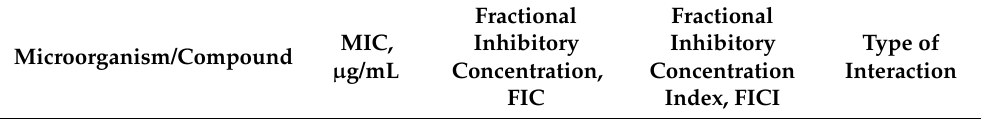
MIC, Microorganism/Compound µ g/mL